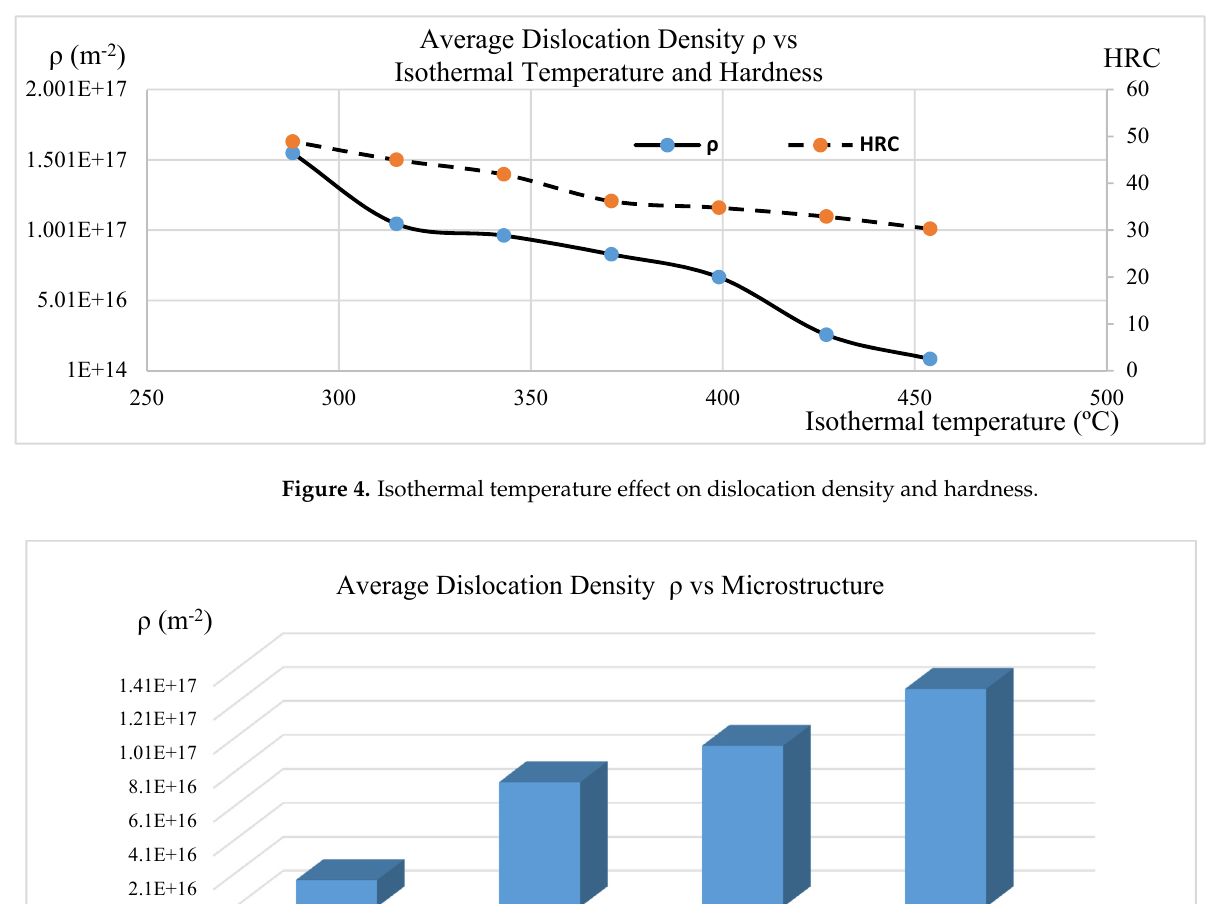
Figure 5. Dislocation density vs. microstructure.